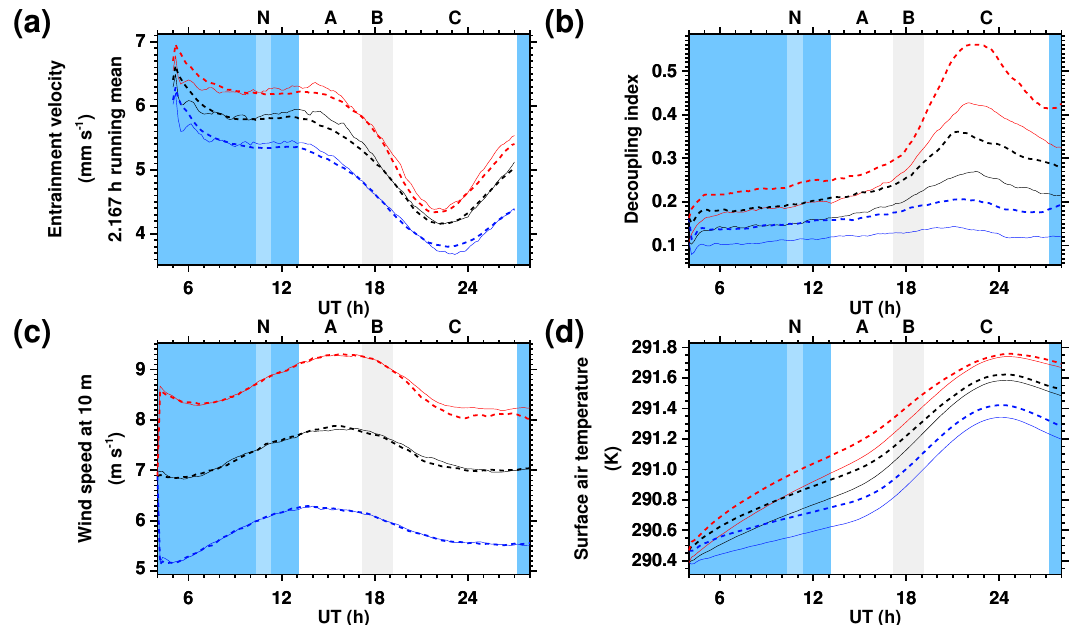
Figure C2. Effect of resolution. Solid curves denote simulations with the base resolution, dashed curves simulations with double resolution in each dimension (Table 2). M − (blue solid), M 0 (black solid), M + (red solid); M − dashed). A low-pass (running mean) filter was applied where indicated to reduce